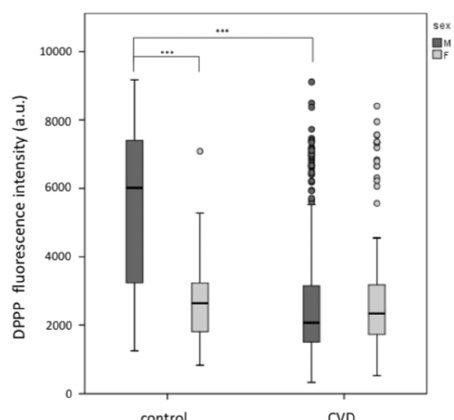
Figure 3. Lipid hydroperoxides (DPPP) in erythrocytes from male and female subjects. Lipid hydroperoxides were higher in the male control group with respect to female controls. Male CVD patients have a lower hydroperoxides level with respect to healthy controls of the same gender. Male controls ( n = 89) and male CVD patients ( n = 269), *** p < 0.001. Female controls ( n = 64) and female CVD patients ( n = 125). Results are expressed as fluorescence intensity (arbitrary units, a.u.).